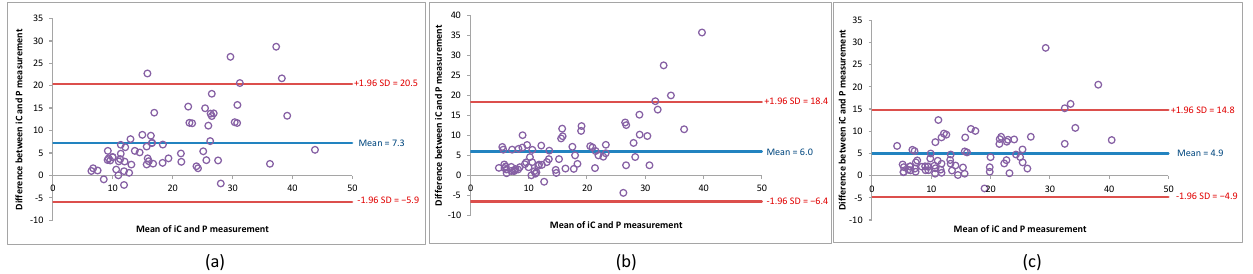
Figure 2. Corneal thickness for glaucoma vs. healthy subjects in the form of box plots.